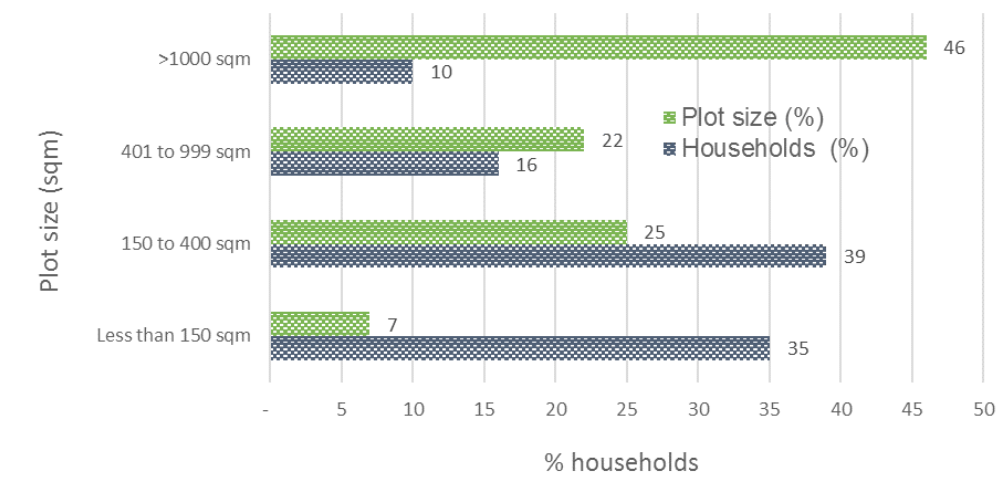
Figure 8: Plot size per household with total size= 106,126